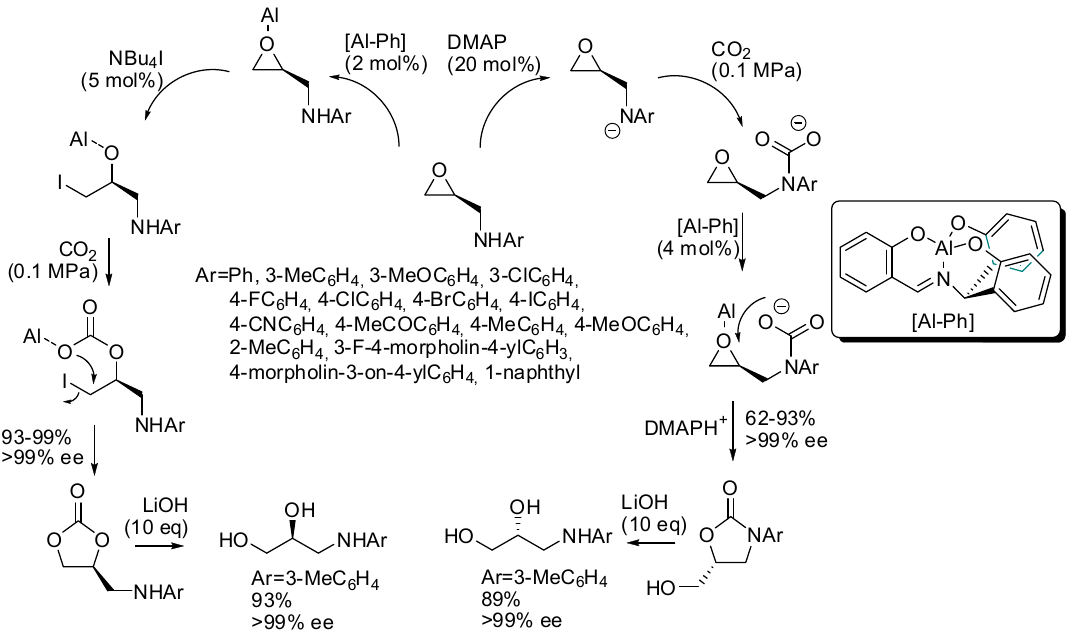
Scheme 5. Stereodivergent synthesis starting from epoxyamines and CO 2.